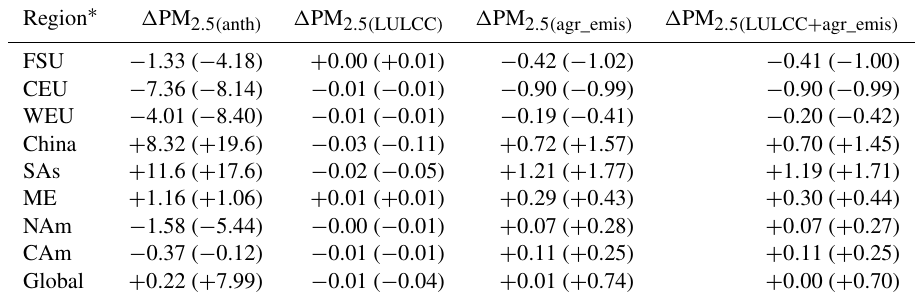
Table 3. Changes in area-averaged and population-weighted (in parentheses) annual mean surface PM 2 . 5 concentrations (in µgm − 3 ) due to anthropogenic emissions alone ( (cid:49) PM 2 . 5 ( anth ) ) , LULCC ( (cid:49) PM 2 . 5 ( LULCC ) ) , agricultural emissions ( (cid:49) PM 2 . 5 ( agr_emis ) ) , and the com- bined effects of LULCC and agricultural emissions ( (cid:49) PM 2 . 5 ( LULCC + agr_emis ) ) together. Results only from regions with (cid:49) PM 2 . 5 ( LULCC )